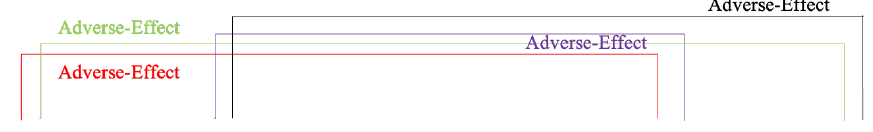
Figure 1. The example is chosen from the ADE dataset, where subjects are marked in orange, objects are marked in blue, and relations are marked with red, green, purple, and black